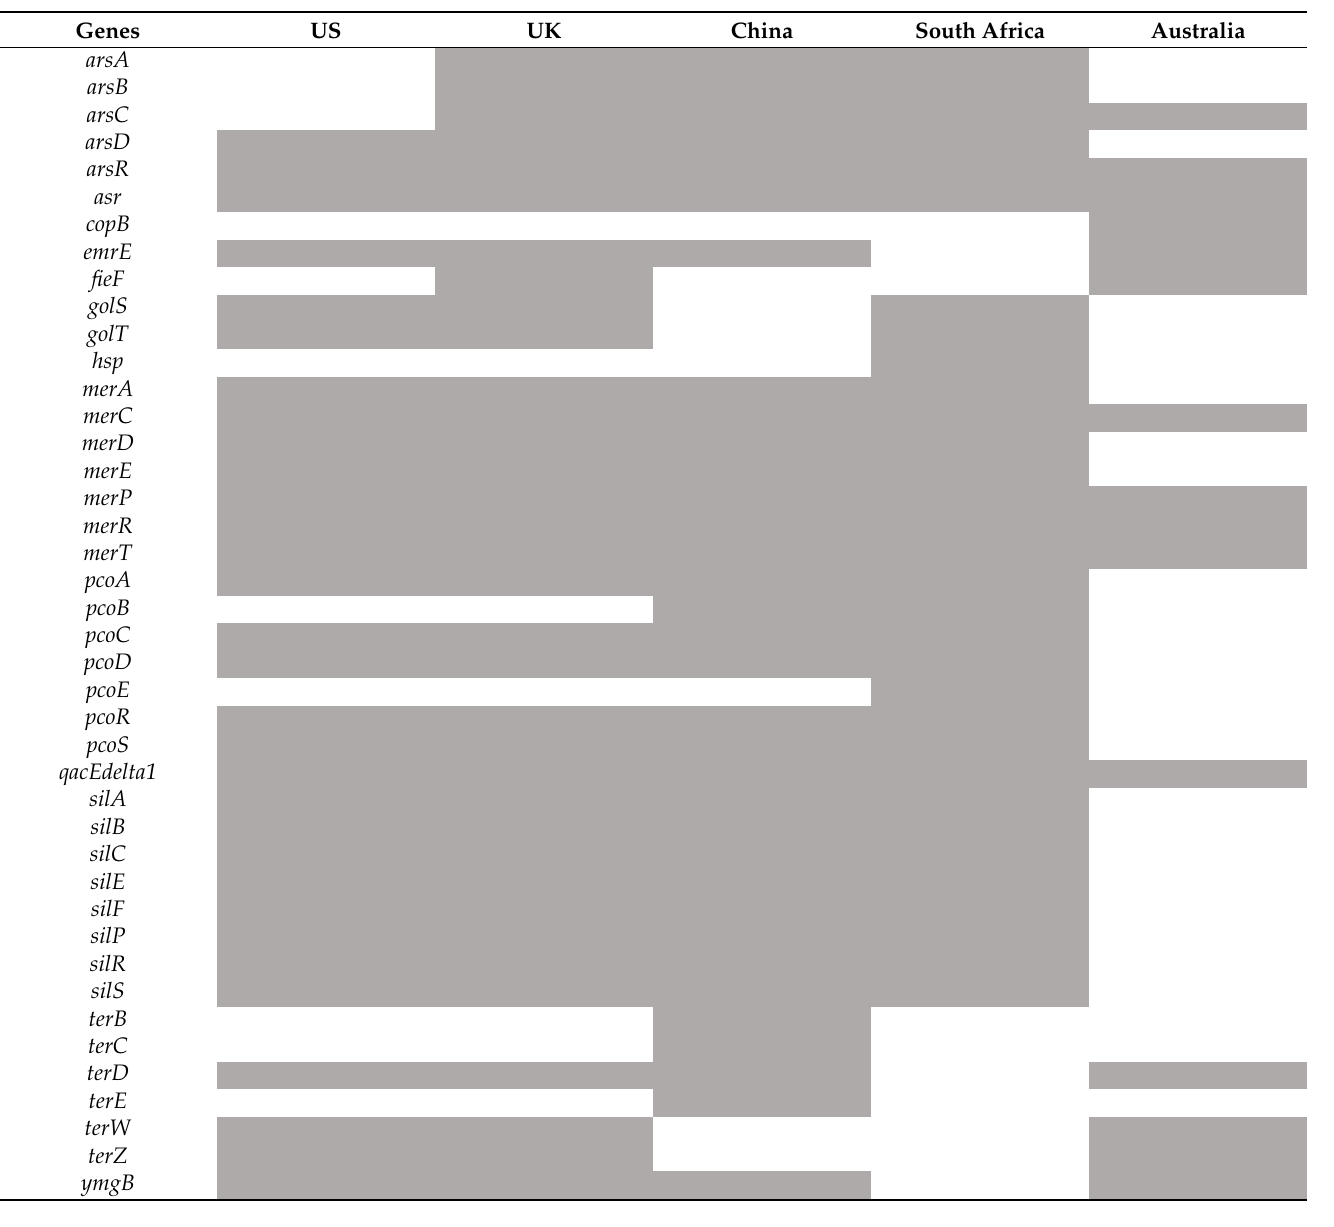
Table 1. Important stress response genes identified for individual countries (marked by the shading).